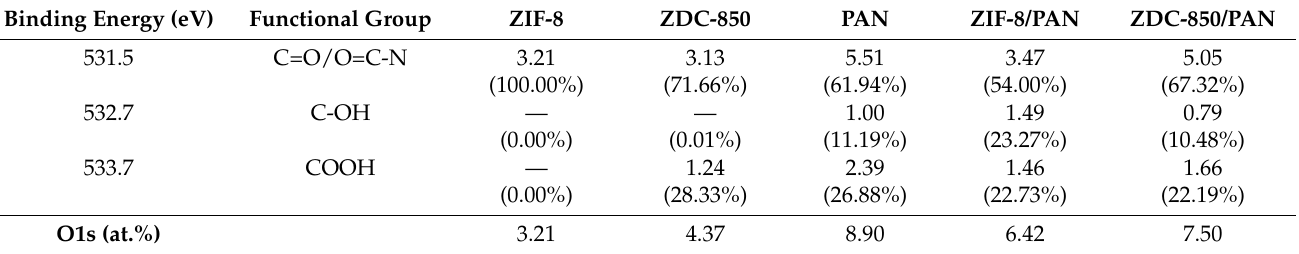
Table 3. Results of the fit of the XPS O 1s region; values given in at.% (percentage total intensity).